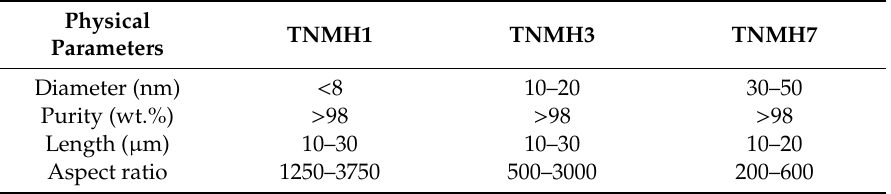
Table 1. The parameters of the carbon nanotubes (CNTs) conductive fillers.